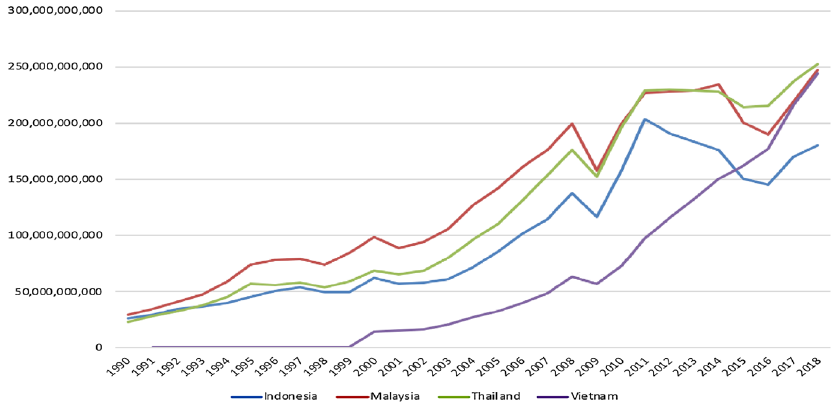
Fig. 1 Export value of selected ASEAN countries in US$. Vertical axis is export value in US$. Source: www. wits. world bank.